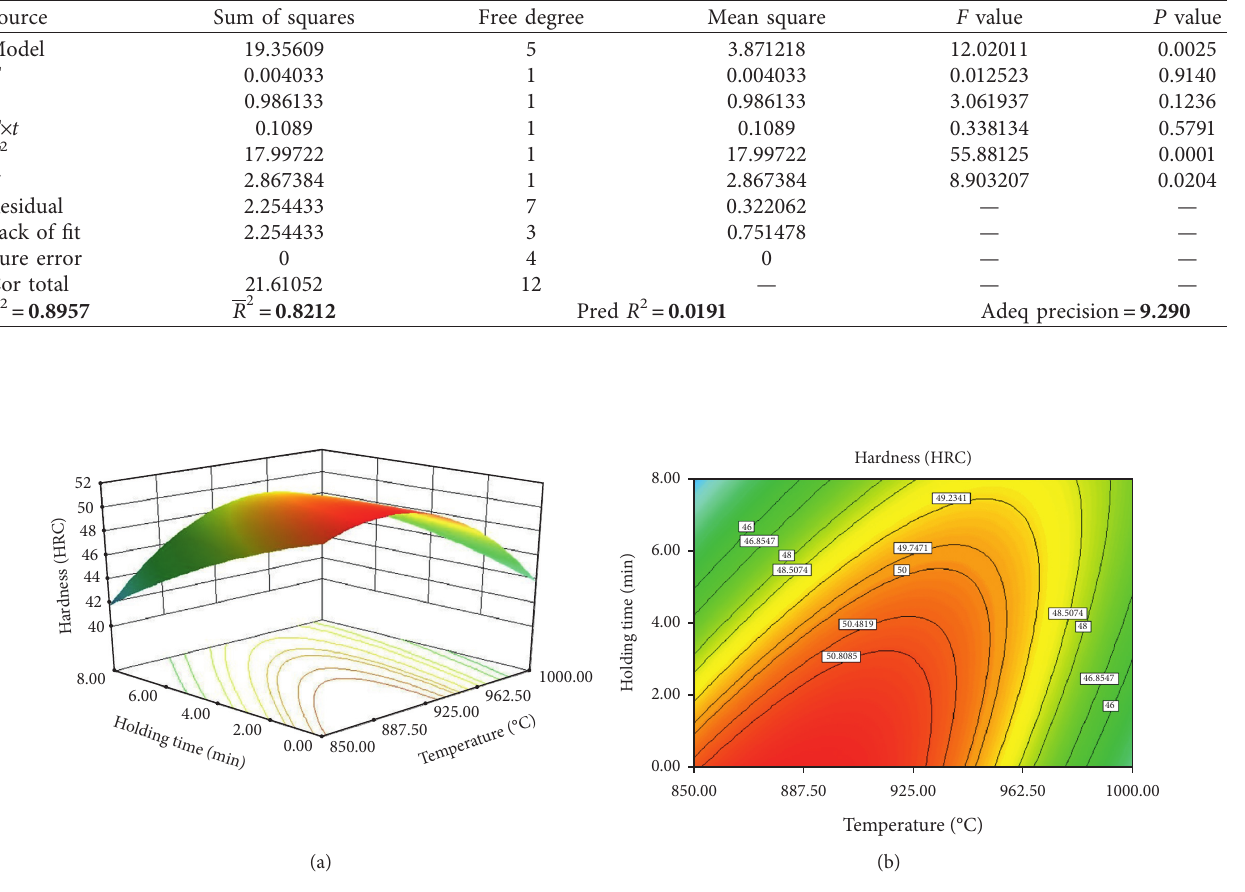
Figure 8: (a) 3D response surface for quenching hardness and (b) 2D contour for quenching hardness.